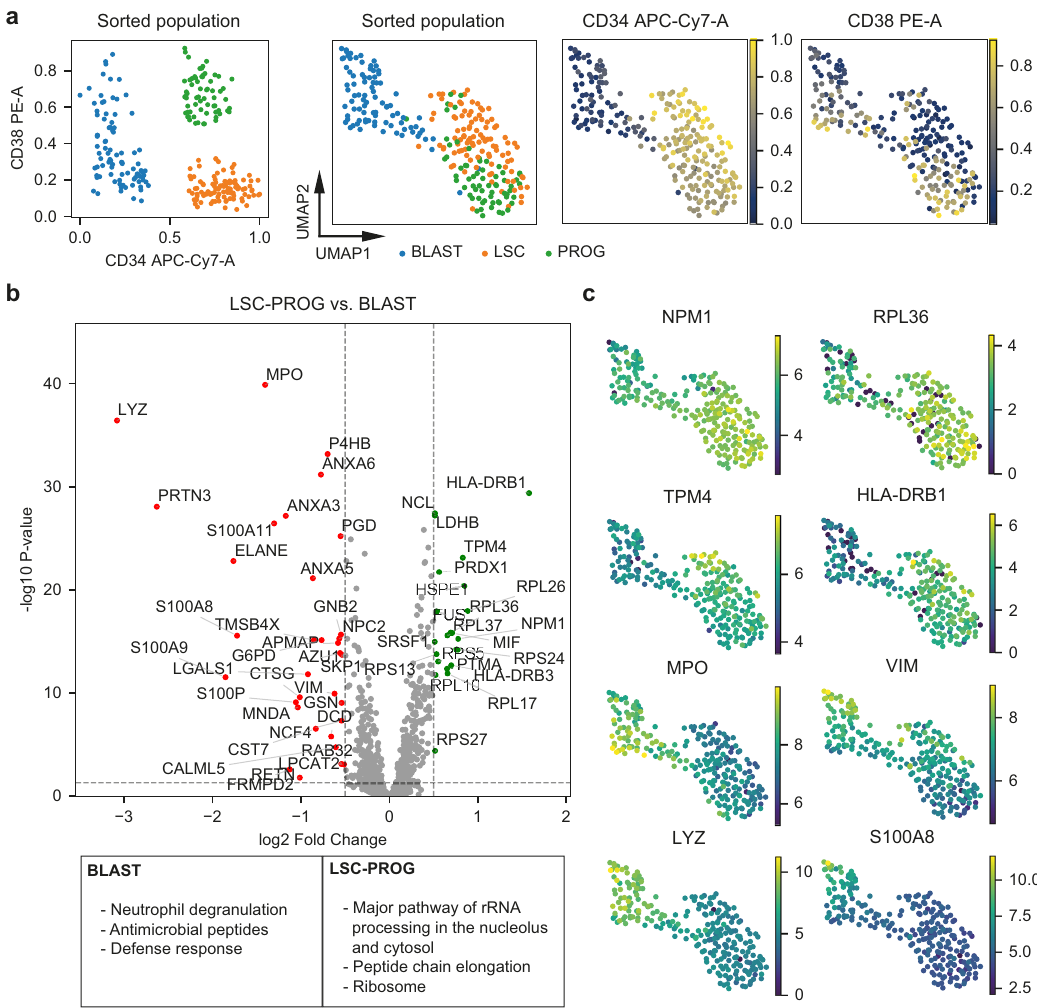
Fig. 4 Extracting biological information from scMS data. a FACS and scMS data from the ‘ high ’ dataset (255 cells). Left scatter plot shows the FACS derived expression of CD34 and CD38 of each cell, colored by differentiation stage annotation (BLAST = blast, LSC = leukemia stem cells, PROG = progenitors). Plots to the right show the UMAP embedding of cells using scMS data (255 cells, 1134 proteins), overlaid with differentiation stage annotation and FACS derived expression of CD34 and CD38. b Volcano plot of differential protein expression between cells labeled as LSC & progenitor and blast. Dashed horizontal line marks the signi fi cance threshold of 0.05 and dashed vertical lines mark the effect size threshold of an absolute log2 fold change of 0.5. Dots represent identi fi ed proteins, with up-regulated proteins marked as green and down-regulated proteins marked as red. The box at the bottom shows signi fi cantly enriched gene terms from the differentially expressed proteins in blasts and LSC & progenitor. c UMAP embedding of cells using scMS data, overlaid with scMS-derived protein expression of selected proteins. Source data are provided as a Source Data fi In total, we processed eight bulk sorted single-cell plates (Supplementary Table 1), three with 1:1:1 booster and fi ve with bulk booster, resulting in a dataset of 2723 proteins across 2025 cells with an average of 987 proteins detected per cell (Supplementary Table 2, Supplementary Fig. 7a). SCeptre successfully removed all